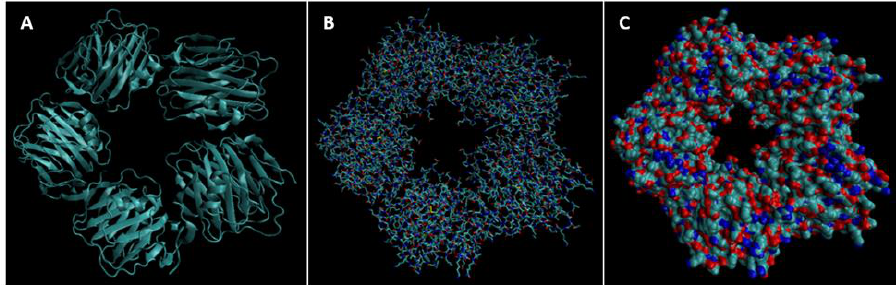
Figure 15. ( A ) A cartoon model, ( B ) a bonds model, and ( C ) a surface model of IL-6.